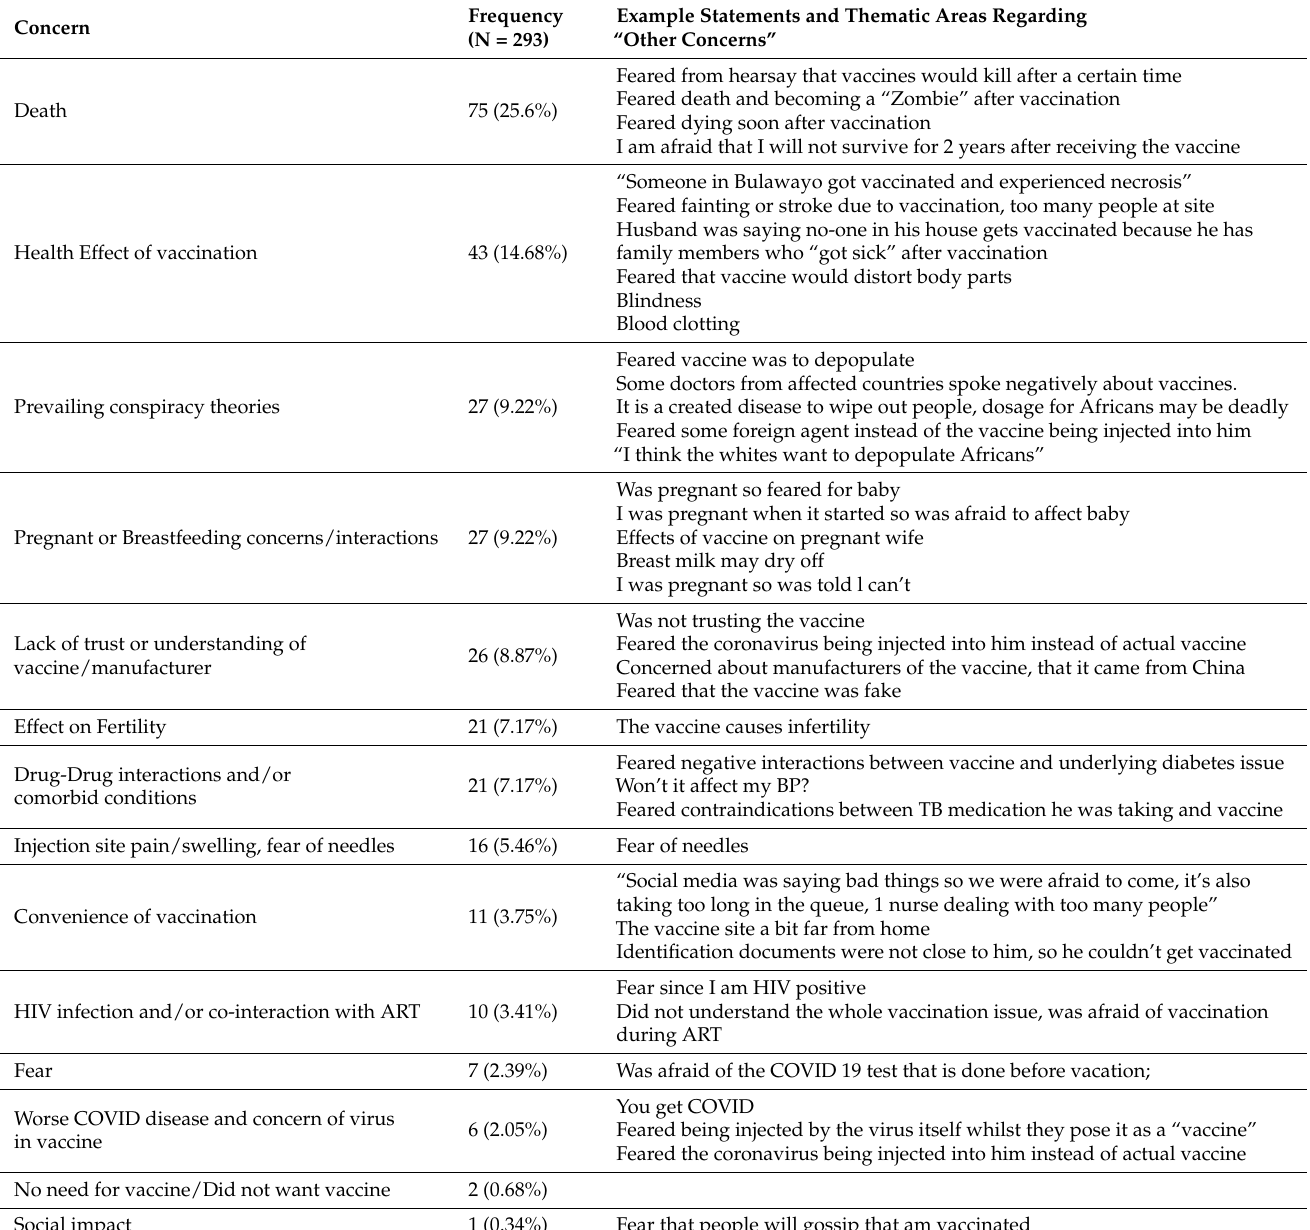
Table 4. Summary of the concerns expressed by study participants who listed concerns as